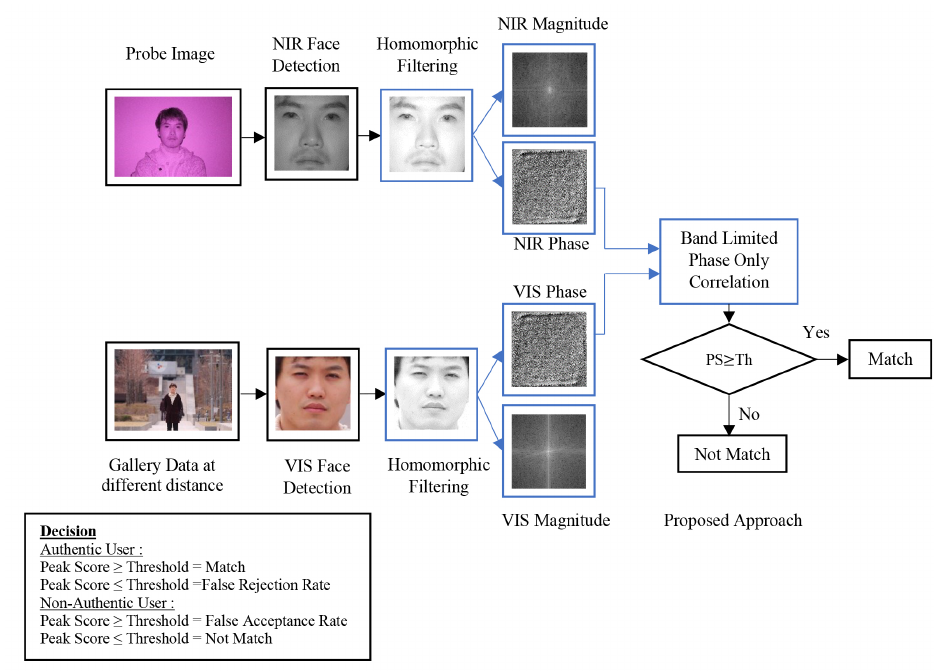
Figure 2. The proposed